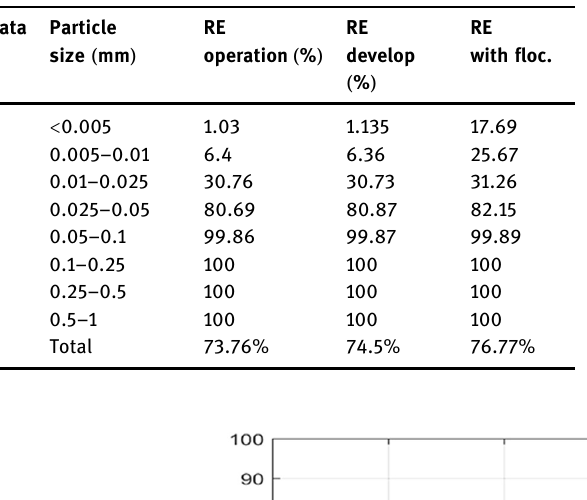
Table 2: Removal e ffi ciency for each particle size of operational and coded models with and without fl occulation unit